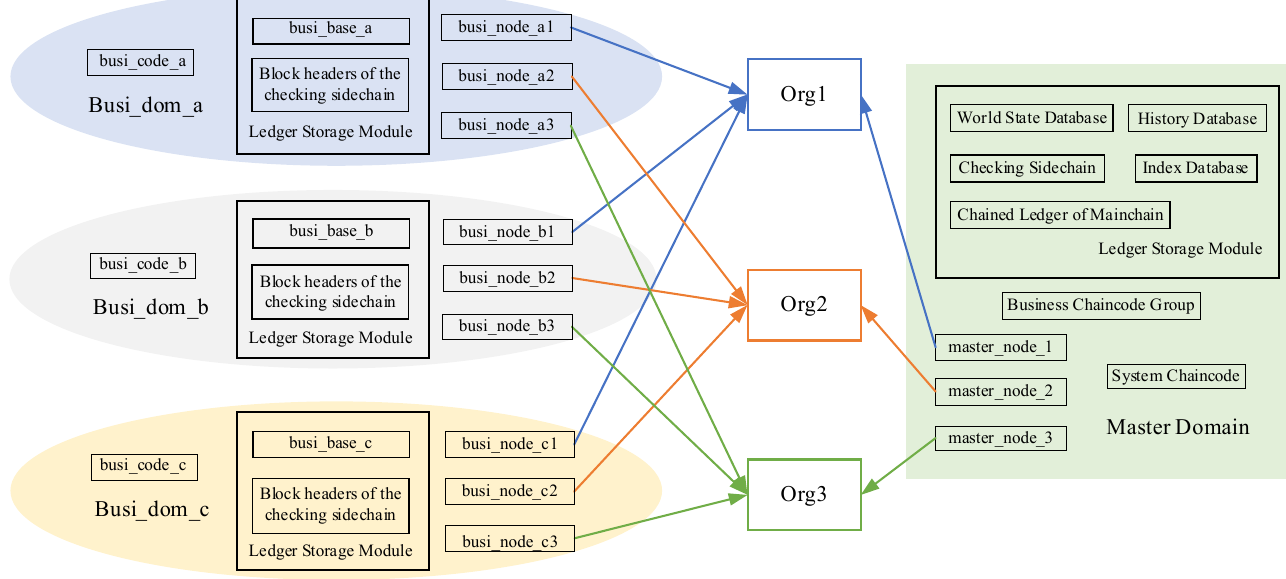
Figure 3. The collaborative storage architecture.